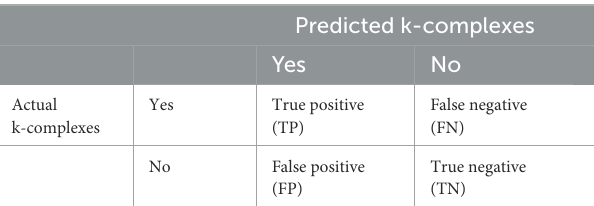
TABLE 2 Confusion matrix of the k-complex detection